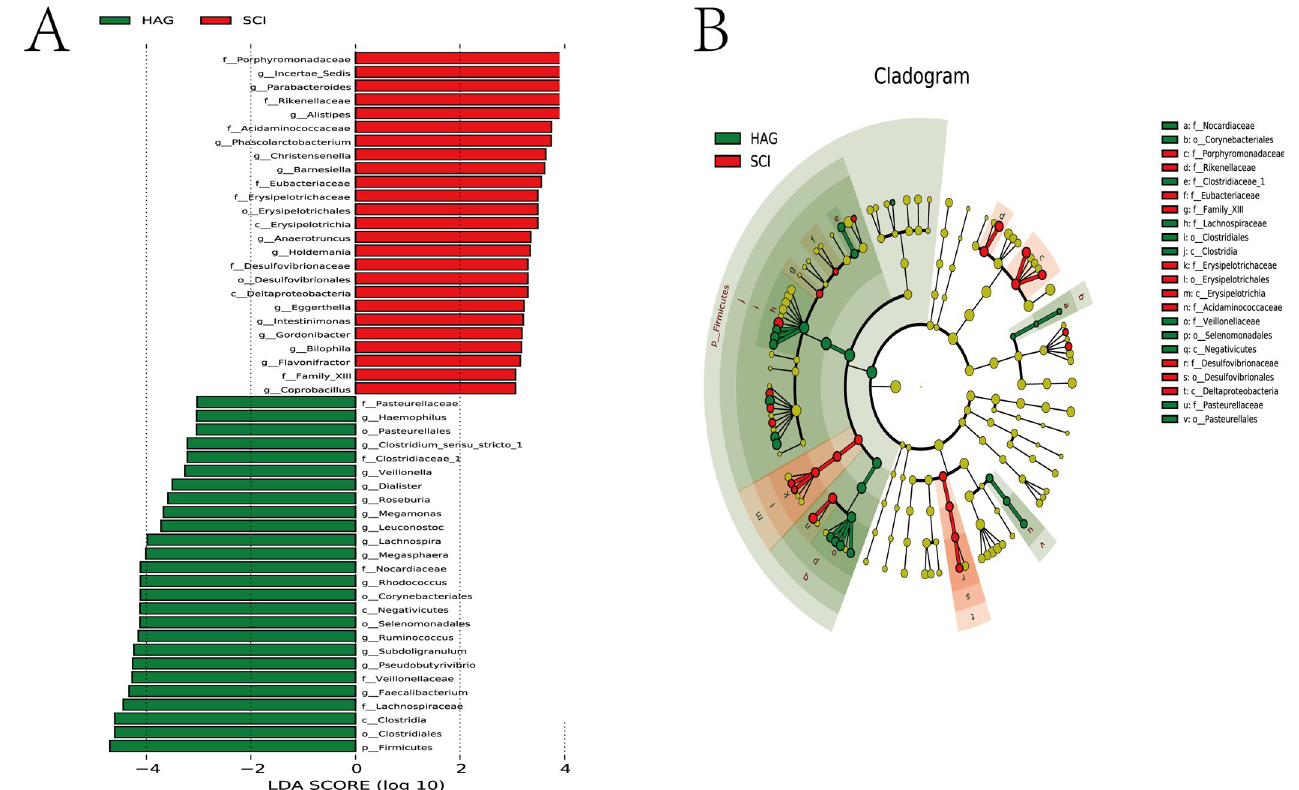
Fig 2. Taxonomic differences of fecal microbiota in the SCI and healthy groups. (A) Linear discriminant analysis (LDA) effect size (LEfSe) analysis showed significant differences in bacterial abundances in the fecal microbiota between the SCI (positive score) and healthy groups (negative score). Linear discriminant analysis scores (log10) > 2 and P < 0.05 are listed. (B) The LEfSe method was used to build a cladogram to analyze the phylogenetic distribution of fecal microbiota associated with patients with SCI and healthy